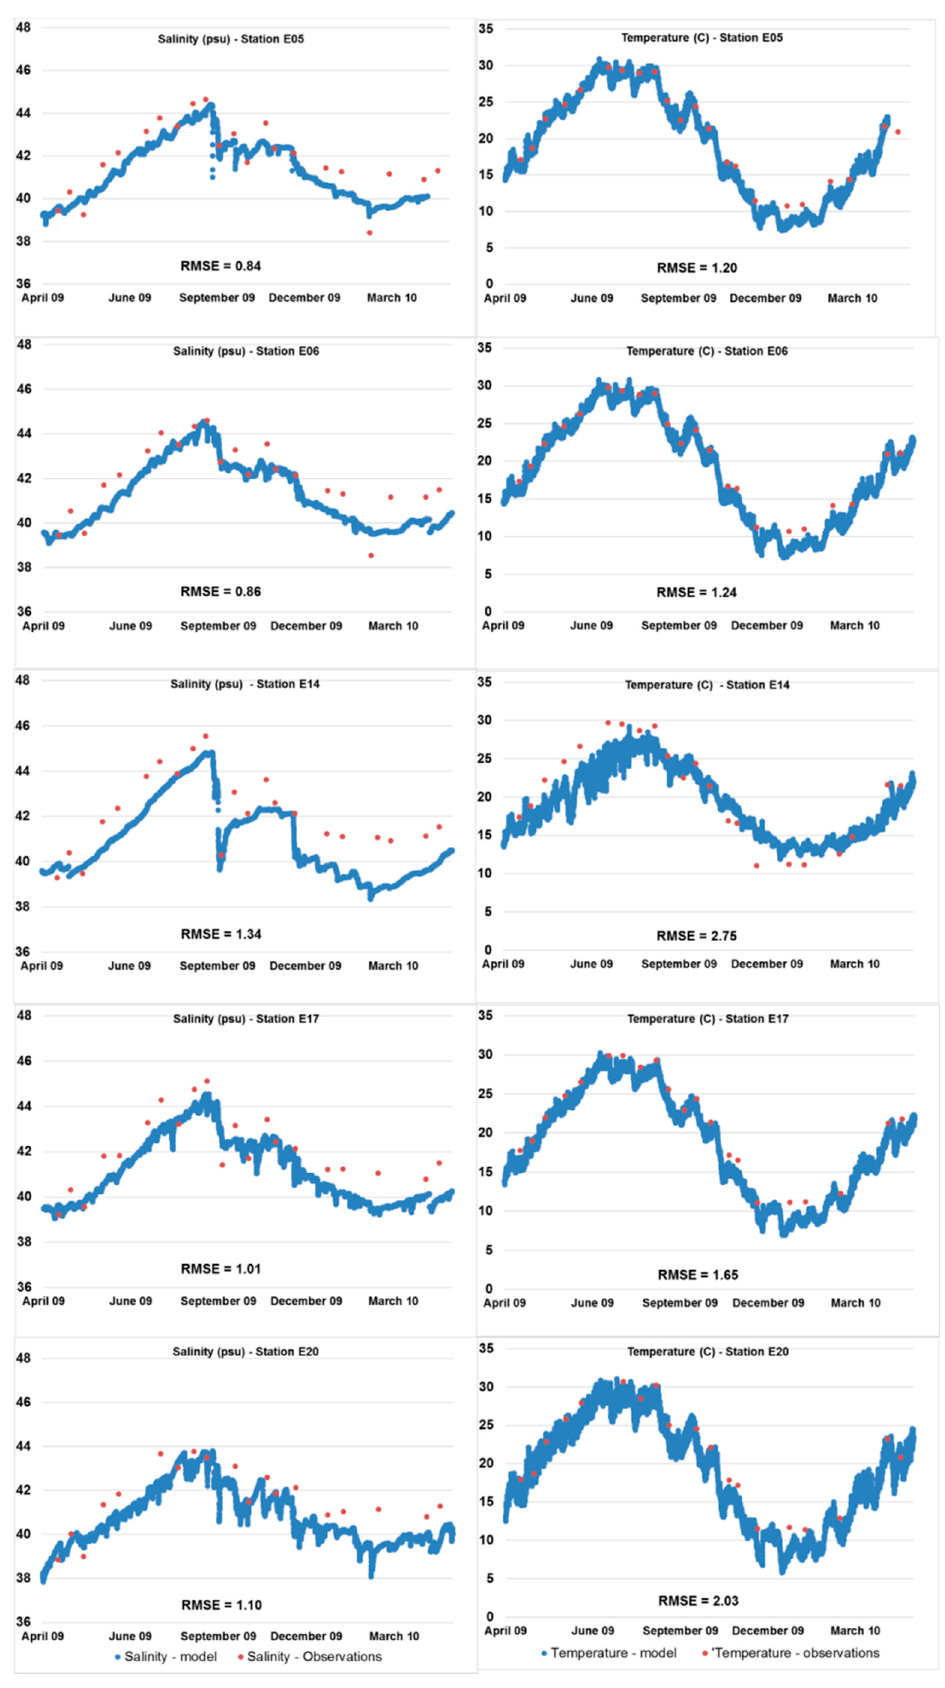
Figure 2. Time series of the modelled (blue curve) and observed (red points) salinity and temperature at the surface layer from different locations.